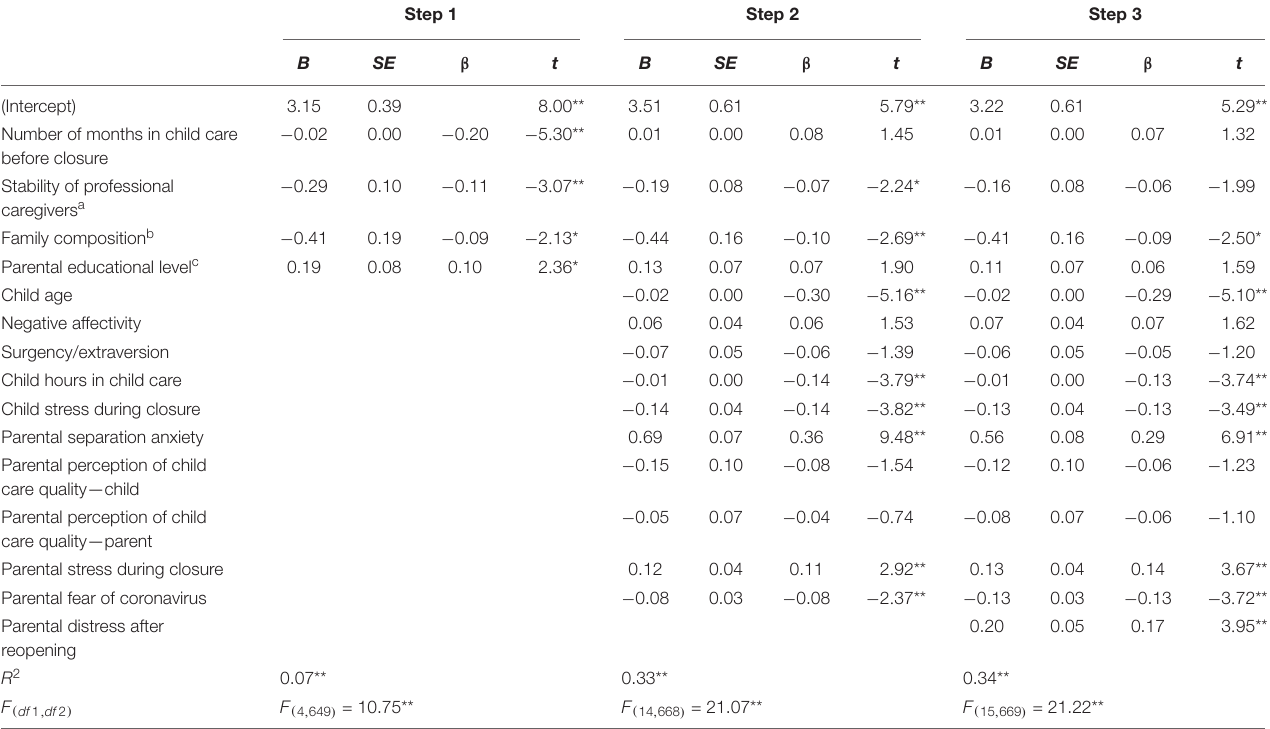
TABLE 3 | Results of the hierarchical multiple linear regression analysis predicting child distress after reopening ( N = 694). Step 1 Step